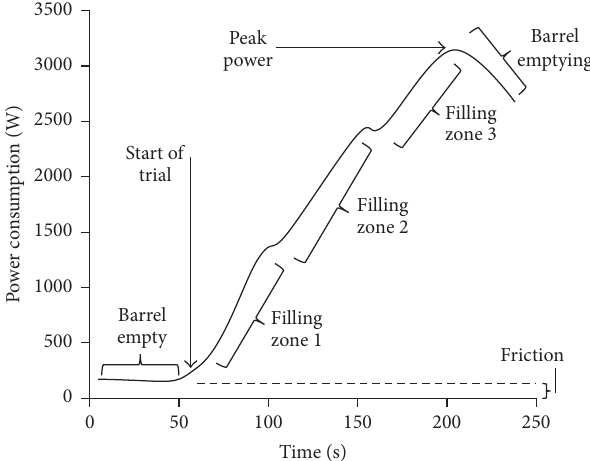
Figure 4: Generalized power consumption curve indicating different regions of power consumption during extrusion.